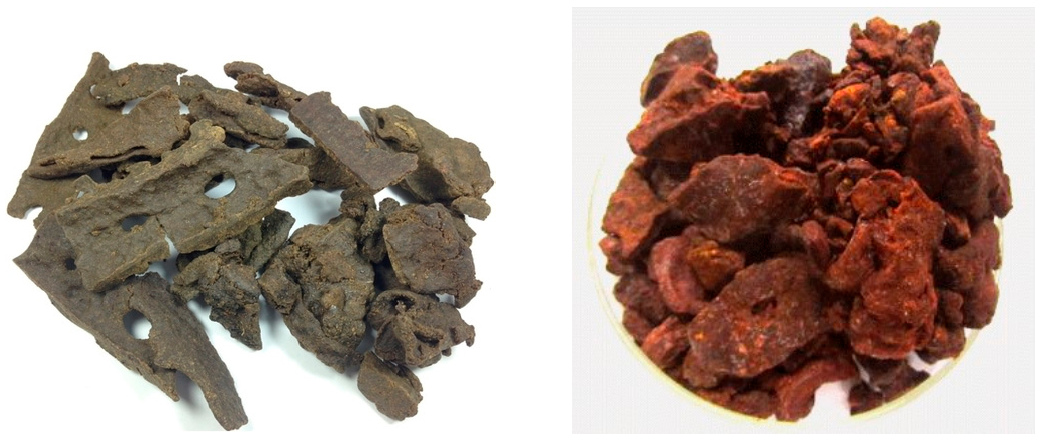
Figure 1. Green and red Brazilian propolis (photo source: [18,19]).